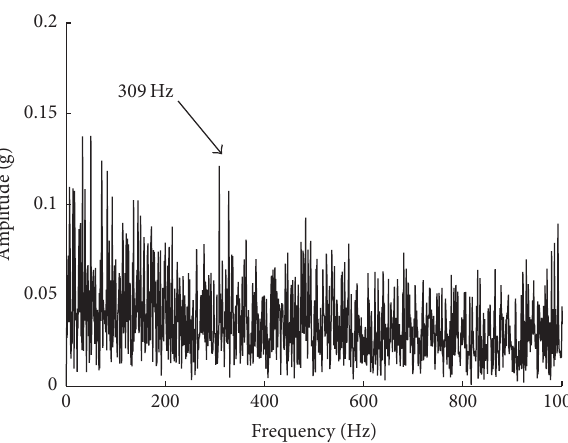
Figure 14: Demodulation result of the 532nd